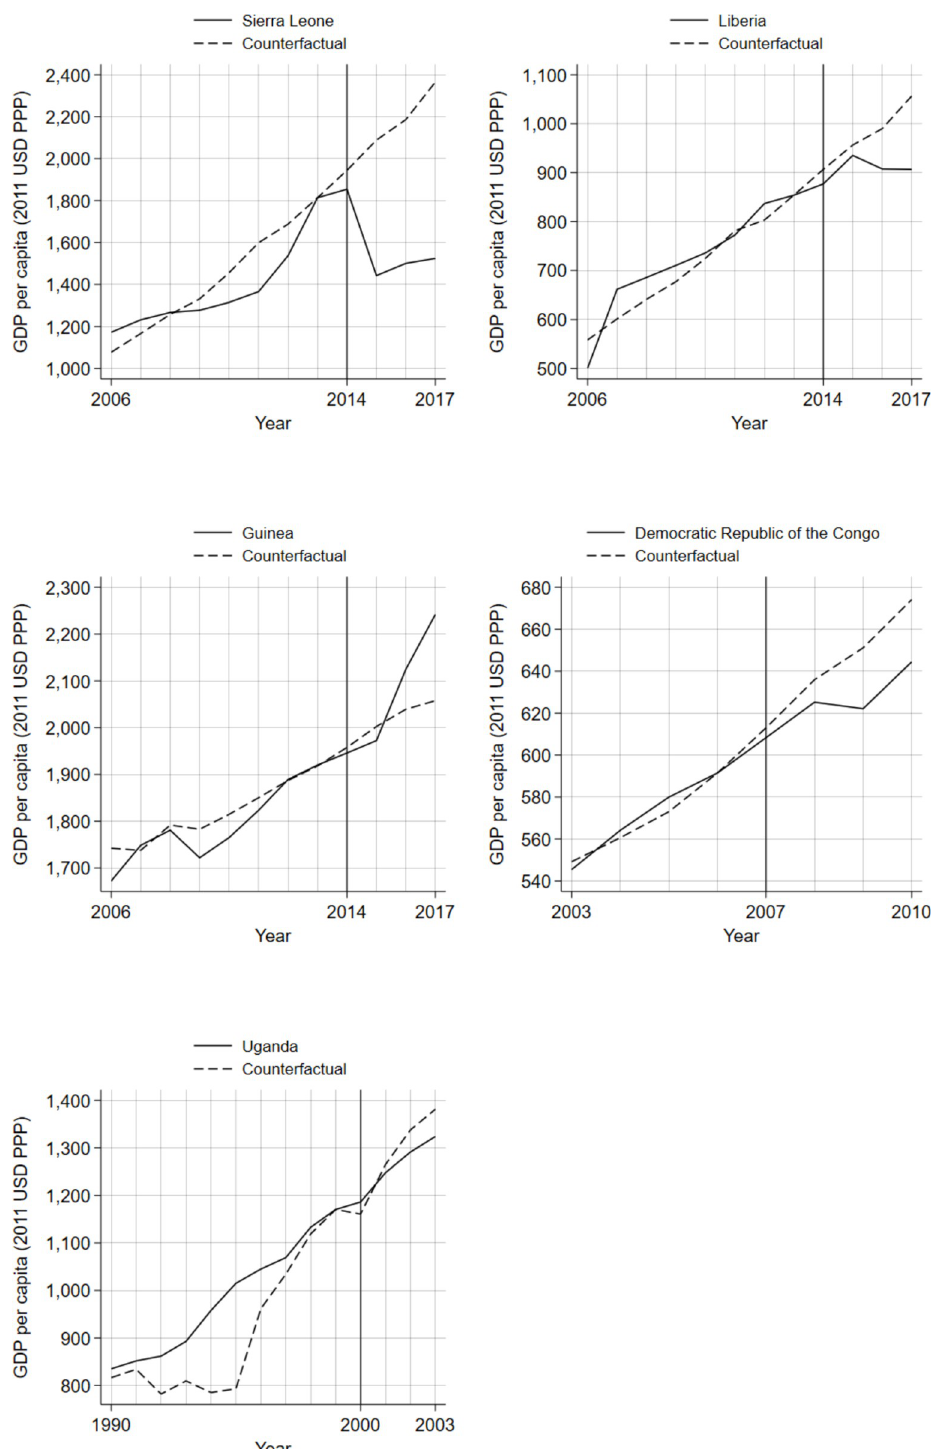
Fig 1. GDP per capita in Ebola-affected countries and synthetic controls. GDP, gross domestic product; USD, U.S. dollars. The start of the Ebola outbreak for each country is indicated by the vertical line.